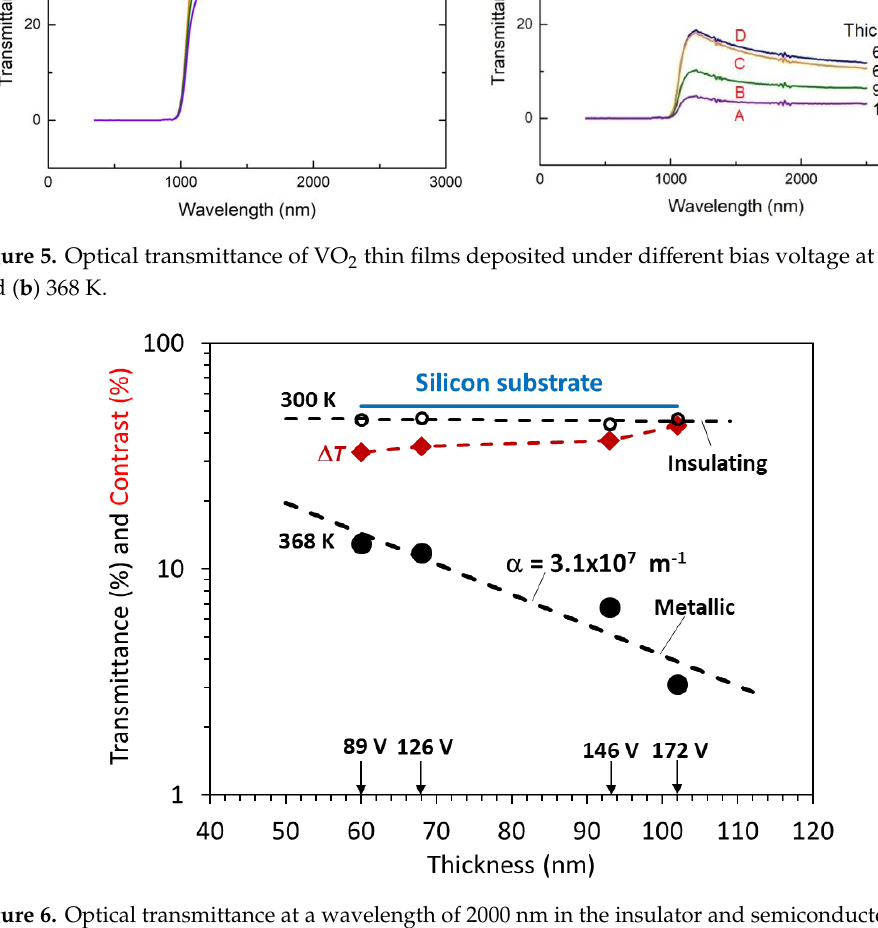
Figure 6. Optical transmittance at a wavelength of 2000 nm in the insulator and semiconductor phases (300 and 368 K, respectively) and contrast T vs thickness on a semilogarithmic plot. The dashed lines are exponential fits. The attenuation coefficient of the metal phase 3.1 × 10 7 m −1 .